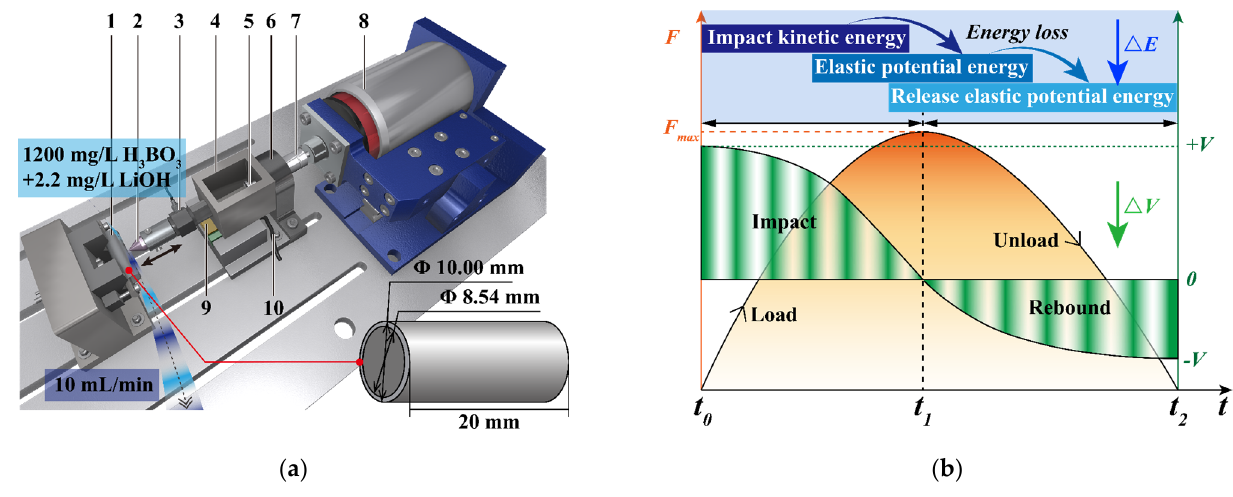
Figure 2. Schematic diagram of self−developed impact wear tester ( a ): (1) tube sample; (2) impact block; (3) force sensor; (4) mass block; (5) tie rod; (6) stop block; (7) damping push rod; (8) voice coil motor; (9) liner guide; (10) displacement sensor, and schematic diagram of motion; ( b ) dynamic response of impact process. Figure 2b the schematic diagram of dynamic response of the impact process.